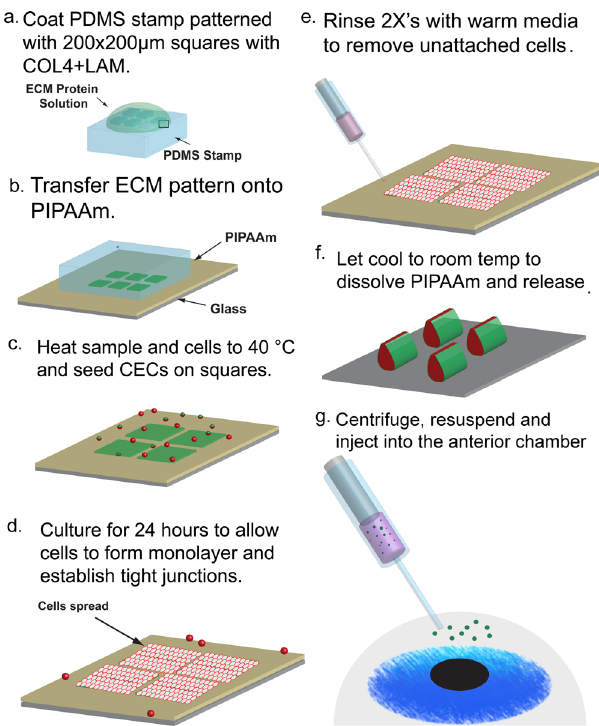
Fig. 1 Schematic representation of the process for shrink-wrapping and injecting corneal endothelial cell μ Monolayers. Steps a , b Surface-initiated assembly techniques are used to engineer 200 μ m square, 5nm-thick ECM scaffolds on the thermoresponsive polymer, PIPAAm. Steps c , d The samples and cells are then heated to 40°C before seeding the cells on the squares and culturing for 24hours. Steps e , f After 24hours, samples are rinsed with warm media and cooled to room temperature to trigger the dissolution of the PIPAAm and shrink-wrapping/release of the µ Monolayers of corneal endothelial cells before injection into the anterior chamber of the eye (Step g